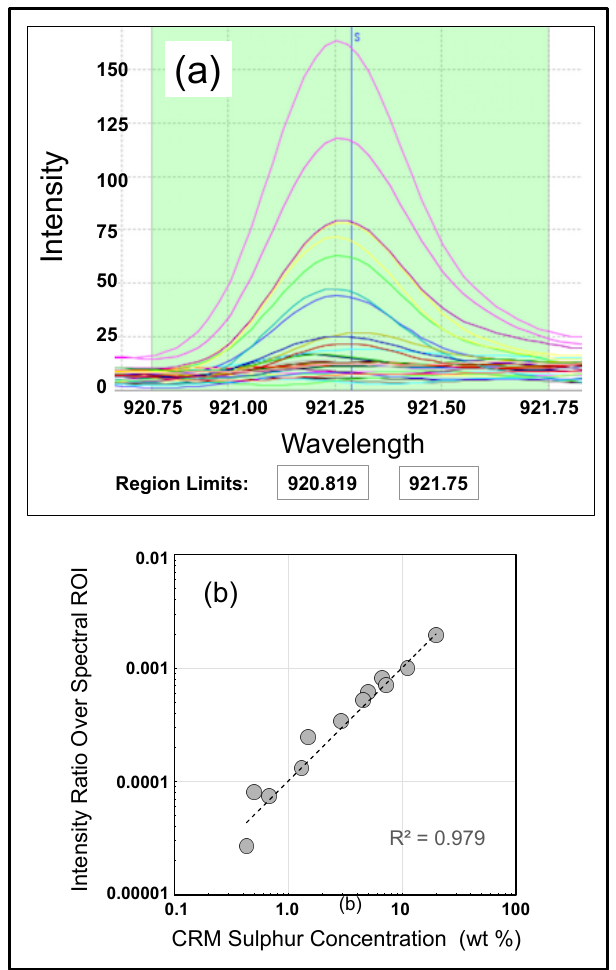
Figure 11. ( a ) SciAps Z-300 Geochem Pro screen display showing the LIBS spectra for S acquired from analysis of 15 Ore Research and Exploration Pty Ltd Assay Standards (OREAS) certified reference materials (CRMs) of known sulfur content over the spectral range of 920.82–921.75 nm, and ( b ) the resulting calibration curve. See text for